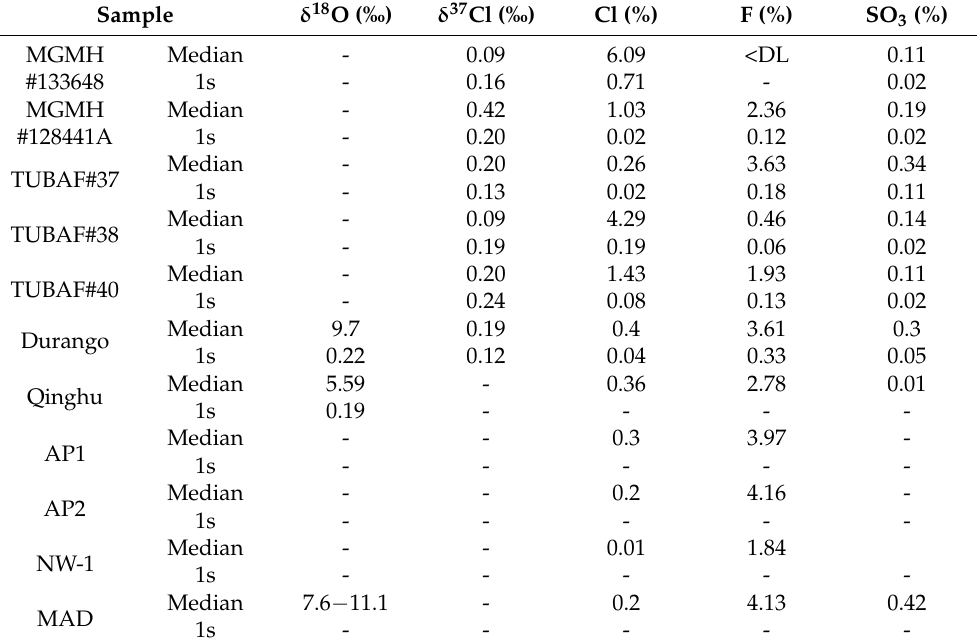
Table 1. The summarized Cl, F, and S concentrations and δ 37 Cl and δ 18 O of the samples used in this